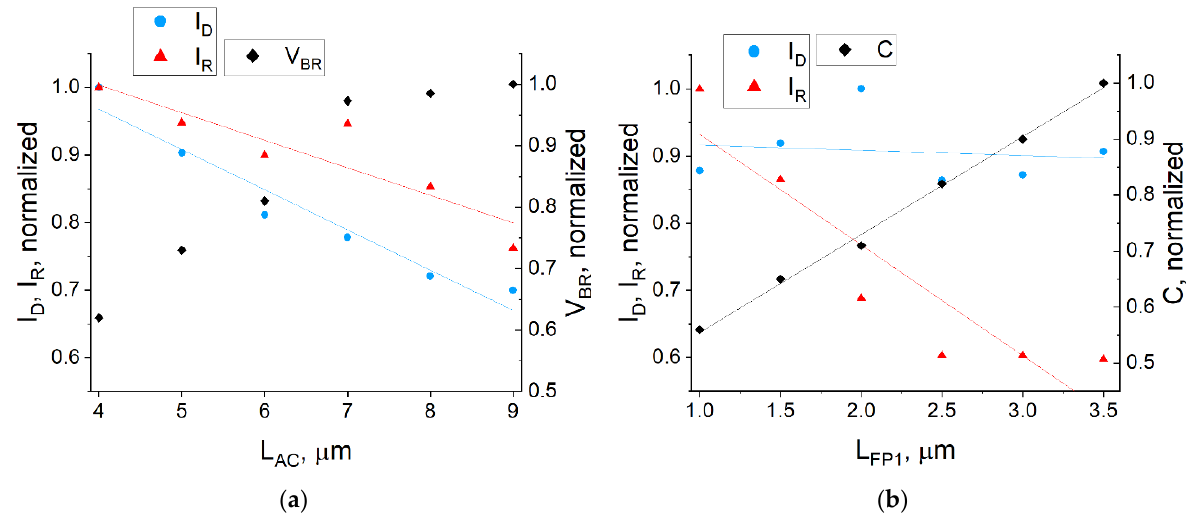
Figure 3. Influence of anode parameters on I F and I R : ( a ) Influence of L AC on I F and I R of GaN SBD; ( b ) Influence of L FP1 on I F and I R of GaN SBD.